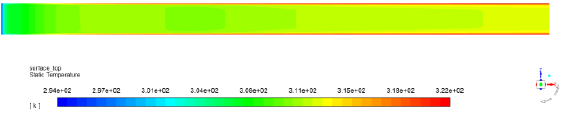
Fig. 11. Static temperature distribution on the contact surface between the working fluid and the heated